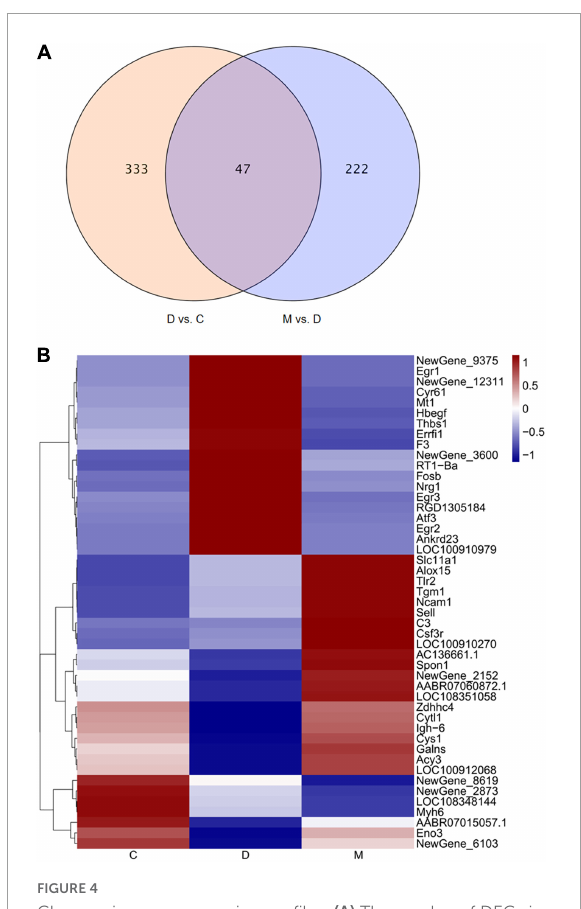
FIGURE5 Functional enrichment analysis by GO and KEGG. (A) Sankey diagram based on analysis of significantly enriched GO terms of the overlapping DEGs in the comparisons D vs. C and M vs. D. DEGs were analyzed using plug-in ClueGO of Cytoscape to determine significantly enriched GO terms. Sankey diagram visualized GO terms and the genes annotated within, where only the most significant terms per group is presented. (B) Significantly enriched KEGG pathways of the overlapping DEGs in the comparisons D vs. C and M vs. D. In bubble chart, the color and size of the points were scaled with respect to adjusted p -values and the number of related DEGs. Gene ratio refers to the proportion of DEGs in each